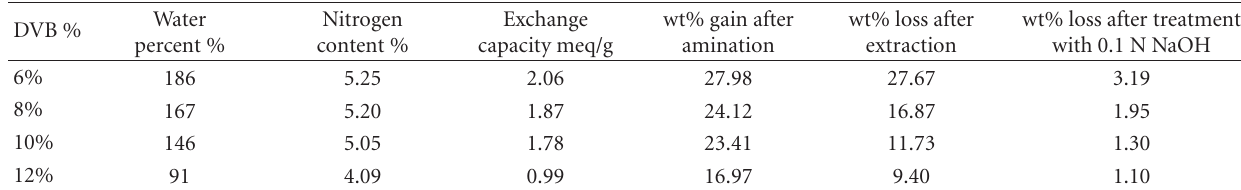
Table 2: Water percent, nitrogen percent, and exchange capacity for polymer prepared with di ff erent DVB ratios prepared by polymerization in xylene and THN then aminated using ethanolic trimethylamine.